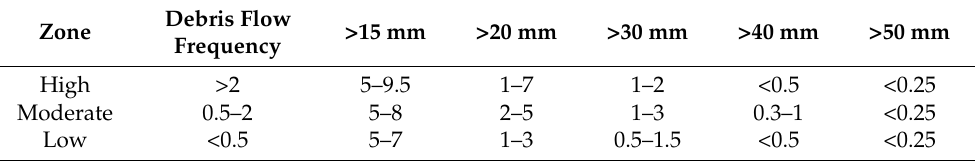
Table 5. Debris flow frequencies and average annual frequencies of daily rainfall >15, >20, >30, >40 and >50 mm in different zones